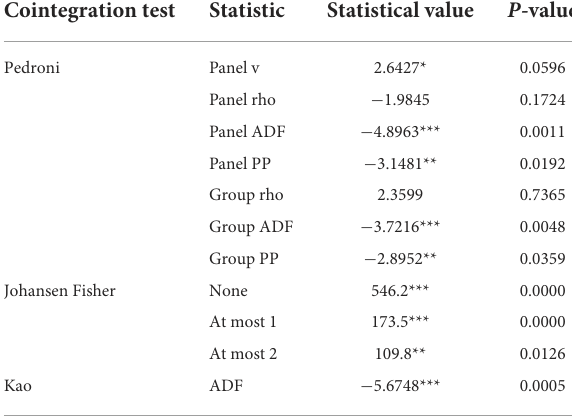
TABLE 3 Panel cointegration test results.